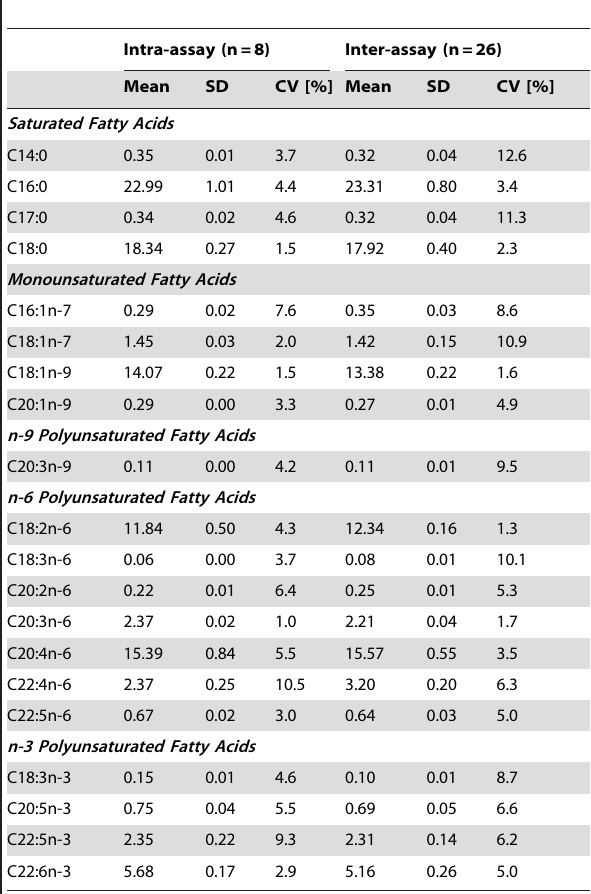
Table 1. Intra- and inter-assay reproducibility of the GPL fatty acid